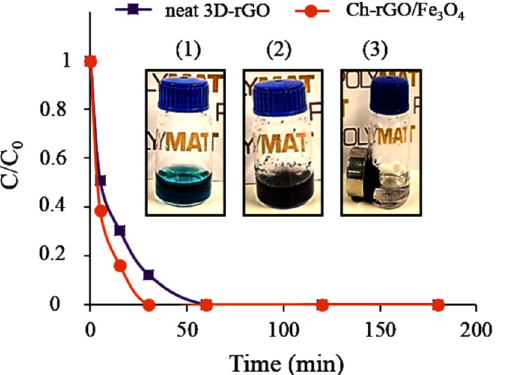
Figure 7. The effect of adsorbent kind on adsorption of AG-25 by neat rGO and Ch-rGO/Fe 3 O 4 . Experimental conditions: adsorbent dosage 0.010 g, dye concentration 0.01 mg mL −1 , RT, and natural pH; Inset: Photos of the discoloration process and separation of the nanostructure afterward.